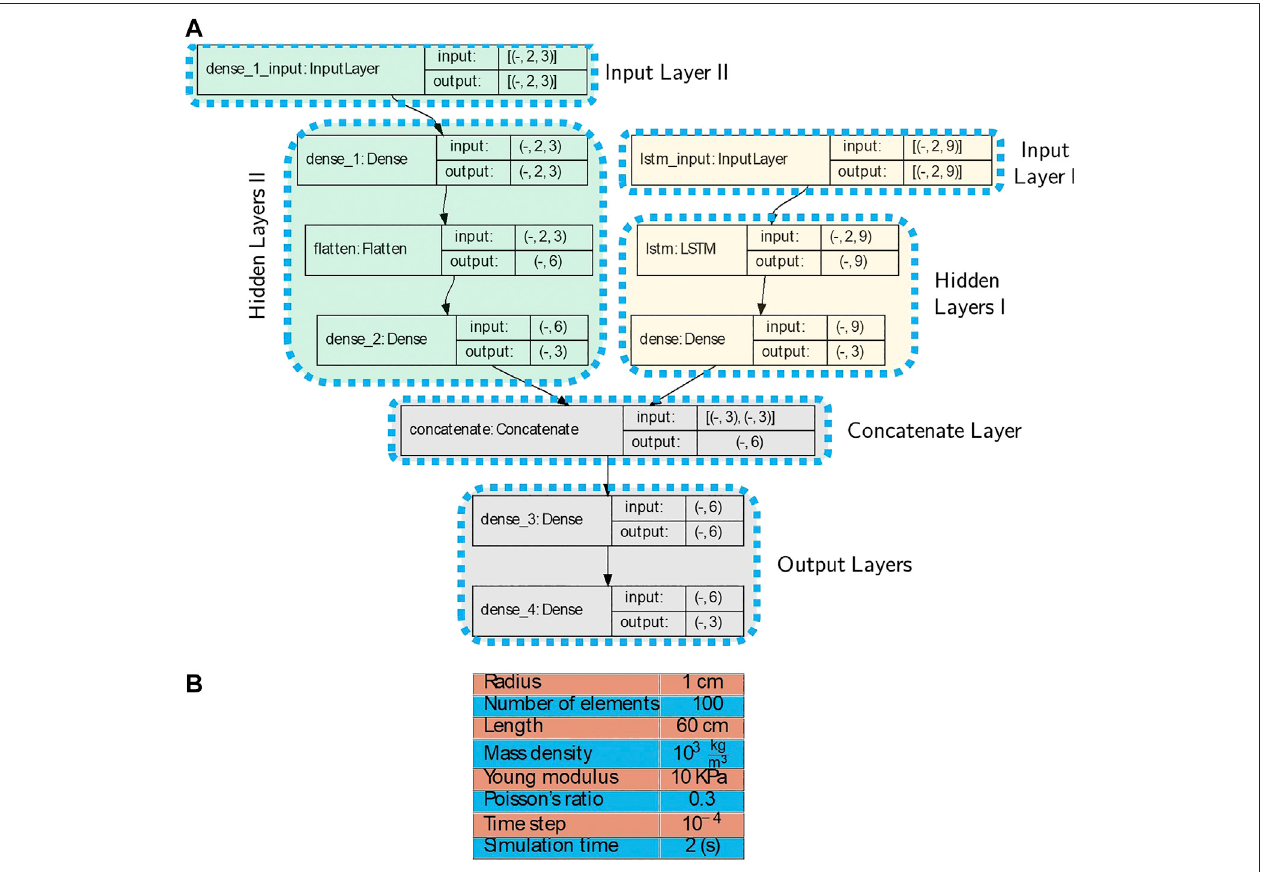
FIGURE7|(A) :Themodelarchitectureusedforthethirdsimulationexample.TherearetwoInputlayers,the fi rstoneistheposesofthenodeandthesecondinput is the applied forces on the node. The fi rst dimension of inputs and outputs in each layer are unspeci fi ed, and can vary with the size of batches (B) : Rod properties and simulation parameters used in the third